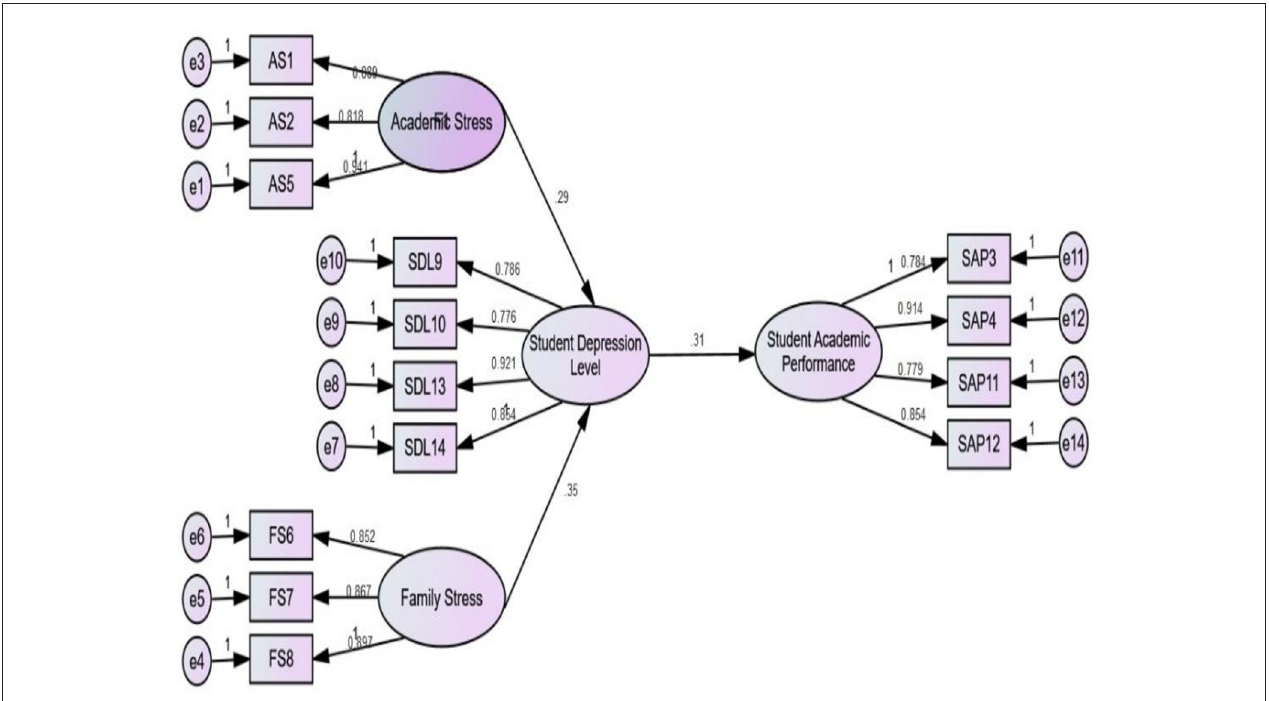
FIGURE 2 | Structural